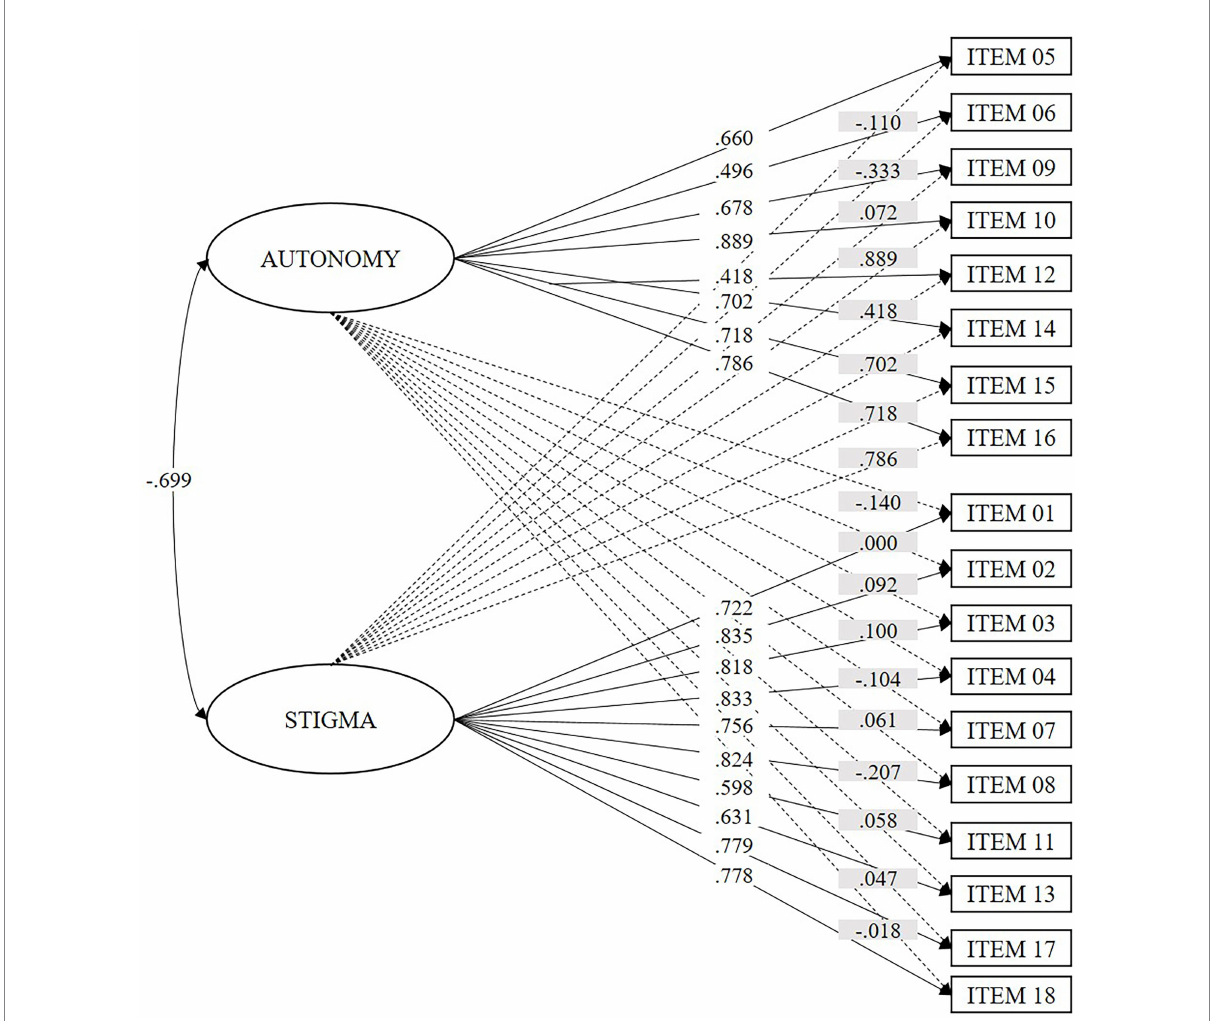
FIGURE 1 Factorial weights of the items in the ESEM model of two correlated first-order factors (Model 3). Values with a white background represent the factorial weights in the factor; values with a gray background represent the